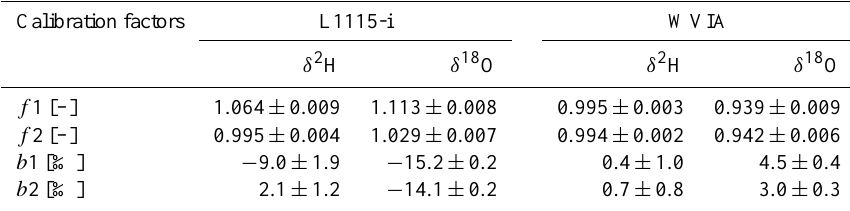
Table 4. Uncertainty in calibration factors following IAEA (2009). The normalisation slopes for both isotopes were determined for two calibration runs 1 ( f 1) and 2 ( f 2) using VSMOW2 and SLAP2 as reference standards. The intercepts of the calibrations from the two runs ( b 1) and ( b 2) are the measured VSMOW2 raw values of the laser instruments.